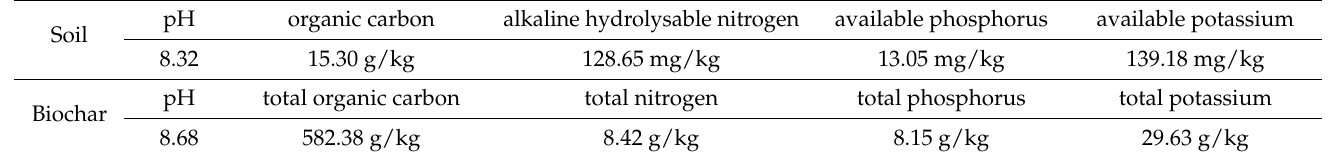
Table 1. Soil fertility and properties of biochar.